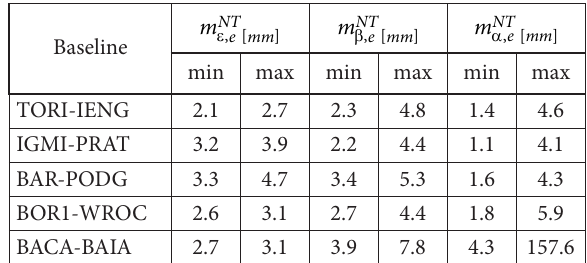
Table 2. Extreme values of epoch-wise standard deviations estimates for the coordinate n and the daytime ( DT ) period Baseline